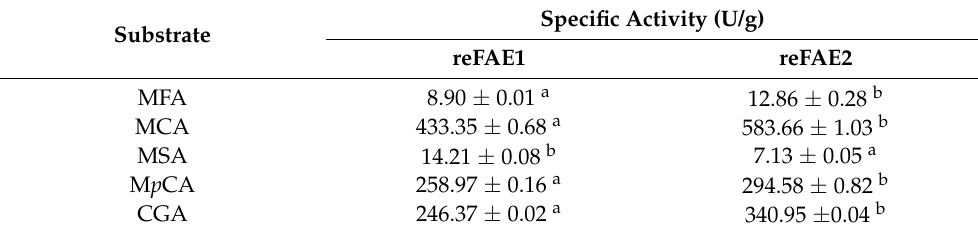
Table 2. Results of purification of